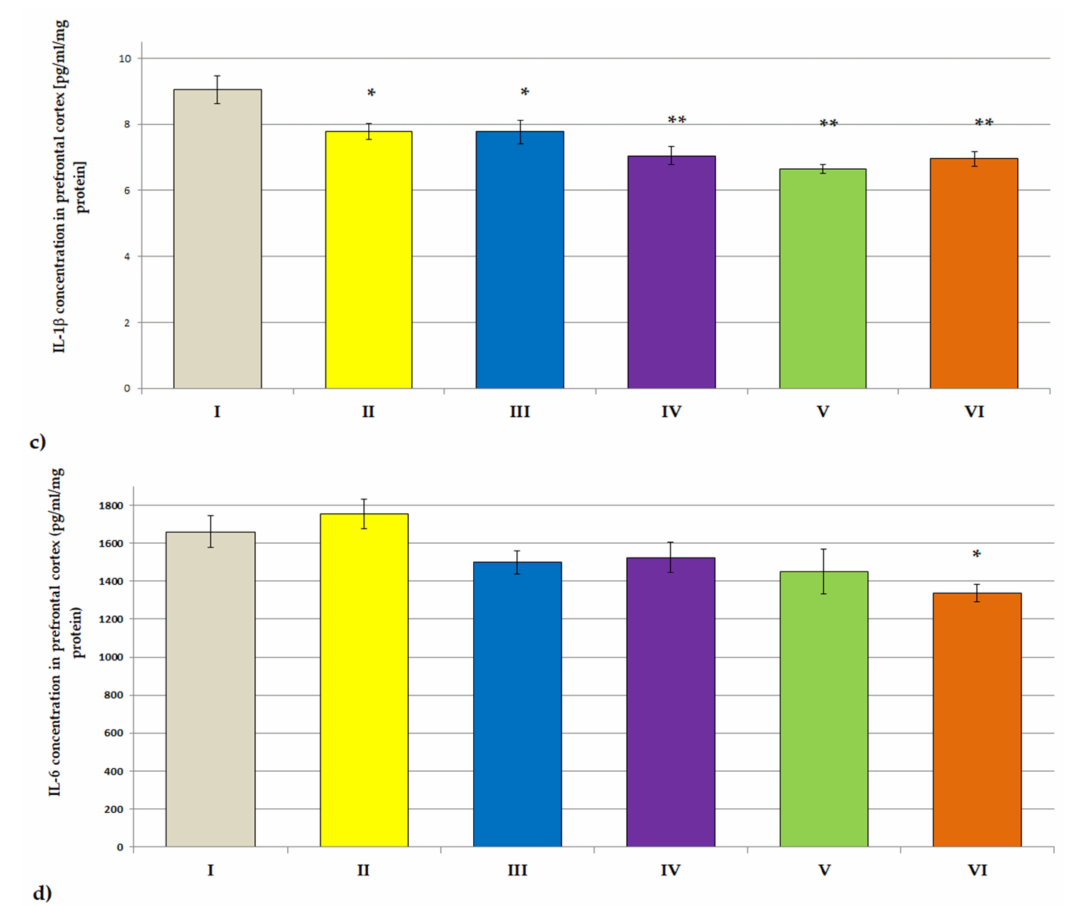
Figure 5. The influence of extracts on the ACHE ( a ) activity, BCHE activity ( b ), IL-1 β concentrations ( c ) and IL-6 concentrations ( d ) in the prefrontal cortex of rats. All values are reported as mean ± SEM ( n = 7). Significance: * p < 0.05, ** p < 0.01 vs. control group (one-way ANOVA followed by Tukey’s post hoc test). I— aqua pro injectione ; II— Narcissus triandrus L. 20 mg/kg; III— Lycopodium clavatum